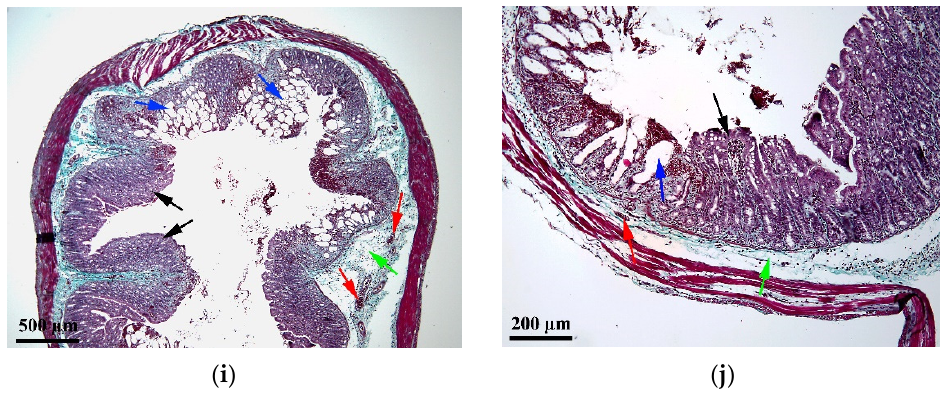
Figure 4. Representative images of colon tissues obtained from the rats included in the in vivo study—histopathological analysis, two images per group. ( a , b ) C, normal control group, overview and detail, respectively—showed a normal mucosa with preserved mucosal folds (black arrows), well-organized crypts with goblet cells (blue arrows); ( c , d ) AA, acetic acid group, overview and detail, respectively—showed generalized hemorrhagic necrosis (red arrows), severe edema (green arrows), altered mucosal folds (black arrows), loss of crypts with goblet cells (blue arrows); ( e , f ) AA_CCS, curcumin group, overview and detail, respectively—showed zonal hemorrhagic necrosis (red arrows), discrete submucosal edema (green arrows), partially preserved mucosal folds (black arrows), loss of crypts with goblet cells (blue arrows); ( g , h ) AA_CCMP, Col-CUR-MPs group, overview and detail, respectively—showed mild congestion (red arrows), discrete submucosal edema (green arrows), preserved mucosal folds (black arrows) and partially preserved crypts with goblet cells (blue arrows); ( i , j ) AA_PLP, prednisolone group, overview and detail, respectively—showed mild congestion (red arrows), discrete submucosal edema (green arrows), partially preserved mucosal folds (black arrows), loss of crypts with goblet cells (blue arrows). The scale bars represent 500 µ m for the images which illustrate the cross-sections’ overview ( a , c , e , g , i ), while for the images which illustrate the details of sections ( b , d , f , h , j ), the scale bars represent 200 µ